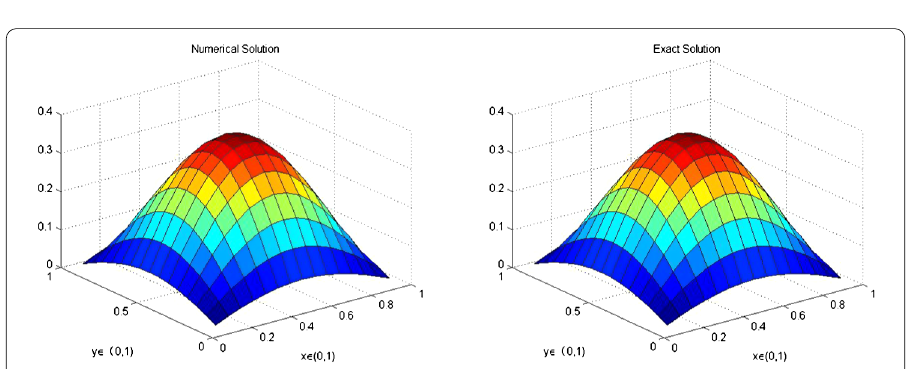
Figure 4 The effect of numerical solution and exact solution at fixed T = 1, h = 1 ( a ) N = 2 4 . ( b ) N = 2 4